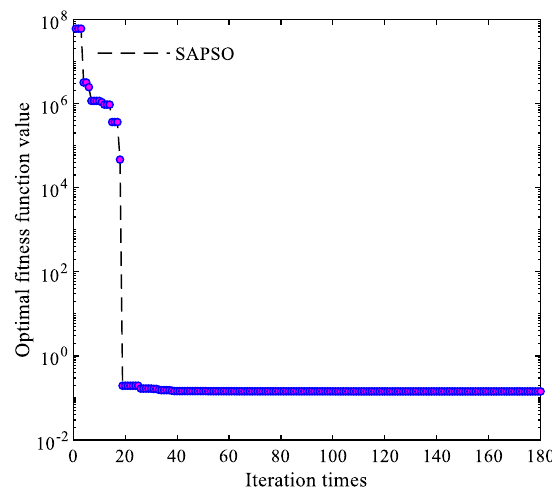
Fig. 5 The relationship between the global optimal fitness function and the number of iterations